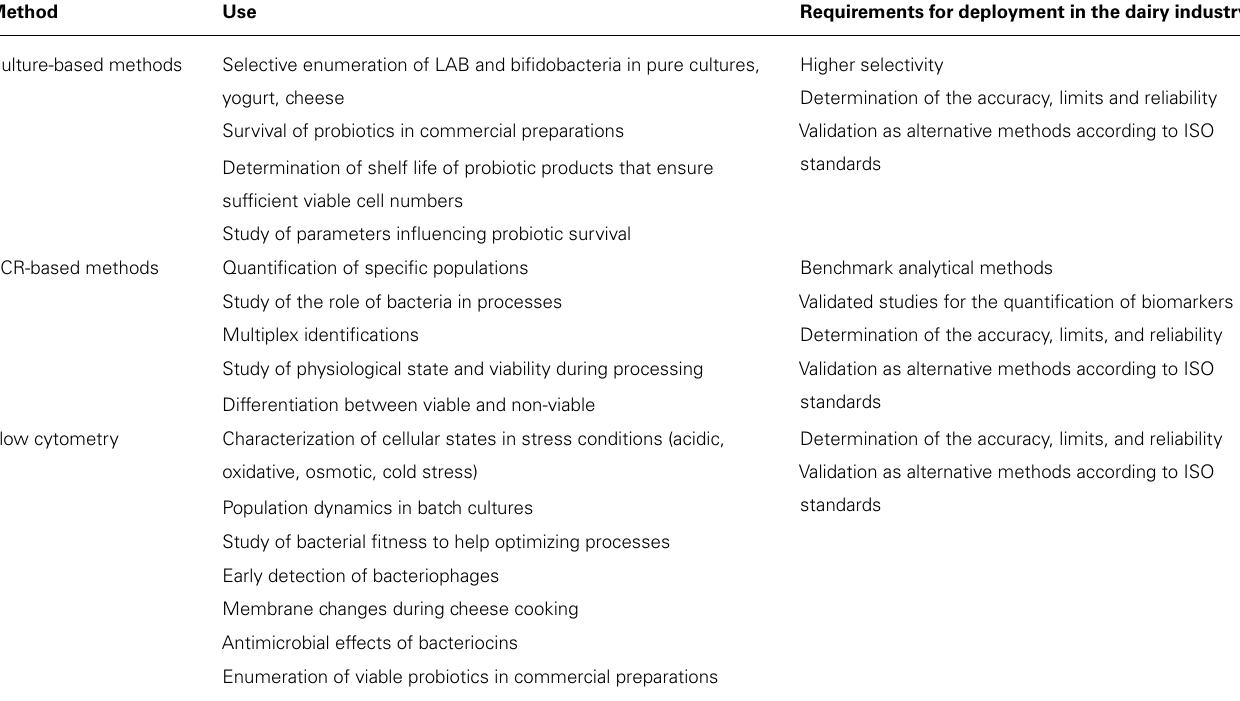
Table 1 | Current uses and lacks of the most employed analytical